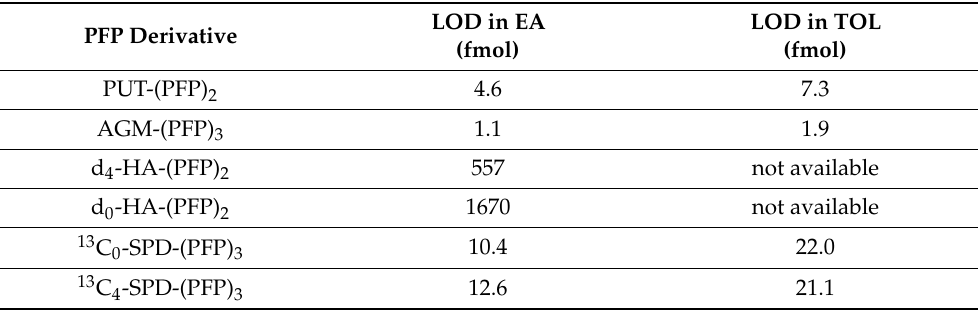
Table 3. Calculated lower limits of detection (LOD) of the investigated amines using ethyl acetate (EA) or toluene (TOL) as the extraction solvent and the starting oven temperature of 40 ◦ C. LOD in EA LOD in PFP Derivative